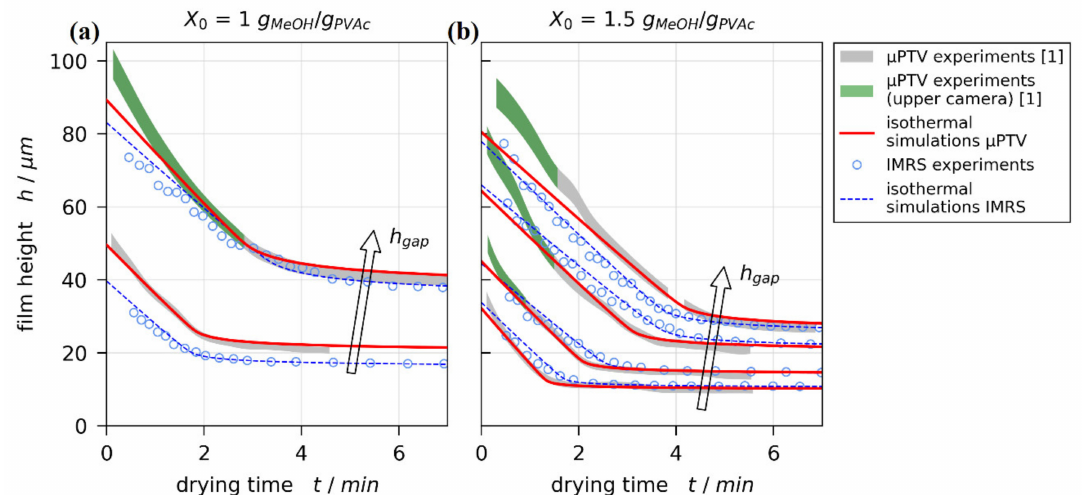
Figure 5. Comparison of drying curves for poly (vinyl acetate)-methanol films at T substrate = 20 ◦ C and ambient drying. The filled areas (gray-green) denote experimental results from 3D- µ PTV measurements accounting for refractive index uncertainty in the evaluation. The green area denotes data recorded with the camera having the highest vertical focus position. Red lines indicate isothermal simulation results with h dry fixed to experimental results. The blue circles and lines denote the experimental IMRS results and matched simulations, respectively. ( a ) X 0 = 1 g 200 µ m. ( b ) X 0 = 1.5 g /g , h gap = 50, 100, 150, and 200 µ m. MeOH PVAc The 3D- µ PTV simulation (red lines) and IMRS results (blue markers and lines) are